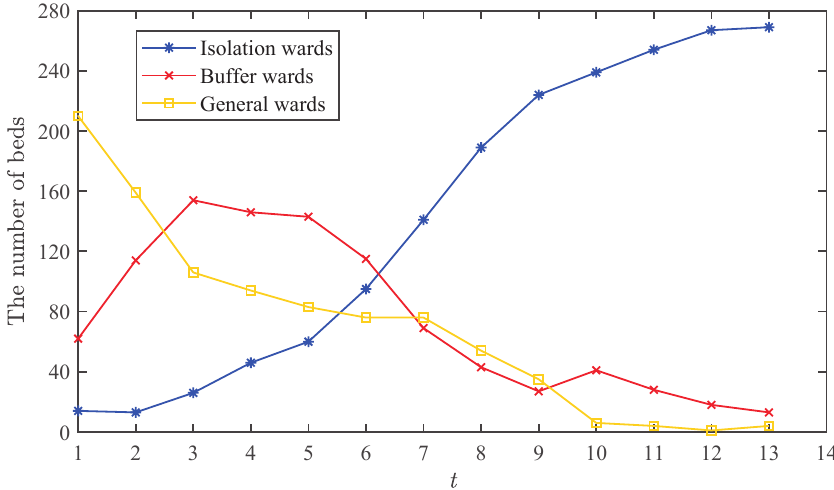
Figure 4. The number of beds in different types of wards.